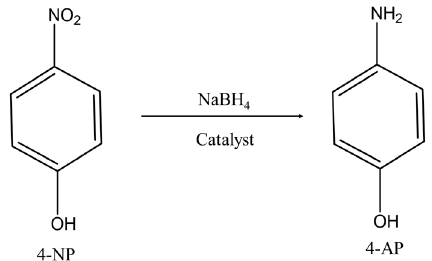
Scheme 1. Catalytic reduction of 4-nitrophenol to 4-aminophenol.